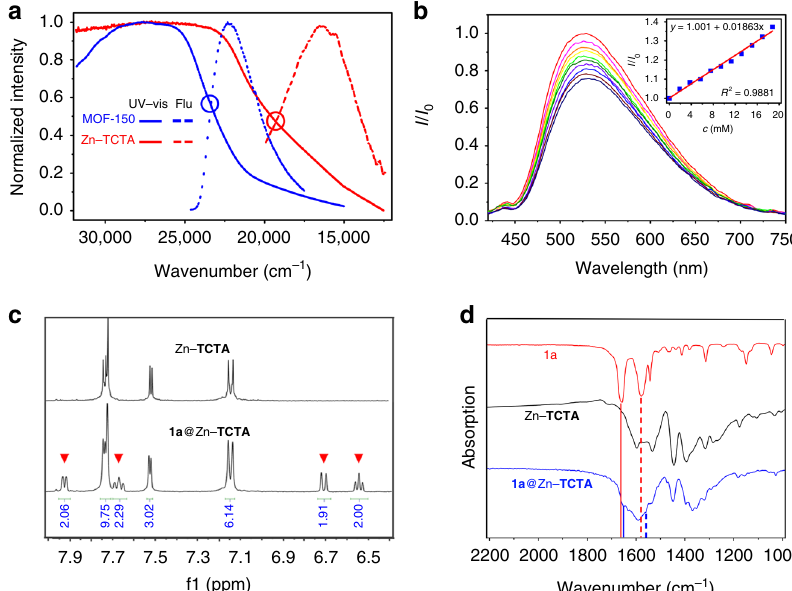
Fig. 2 The host – guest interactions between Zn – TCTA and substrate/reagent. a Normalized absorption and emission spectra of Zn – TCTA ( ν 0 – 0 = 19,274 cm − 1 , E 0 – 0 = 2.39 eV) and MOF − 150 ( ν 0 – 0 = 23,468 cm − 1 , E 0 – 0 = 2.91 eV) excited at 390 and 350 nm, respectively. b Fluorescence spectrum of Zn – TCTA upon the addition of tri fl uoromethanesulfonyl chloride (TfCl) and the corresponding simulated Stern – Volmer curve (inset of b ) excited at 390 nm; the intensity was recorded at 546nm. c 1 H NMR spectrum of the crystals of Zn − TCTA and 1a @Zn − TCTA (digested in DMSO- d 6 /DCl). Peaks marked with inverted red triangles represent the aromatic signals of the encapsulated substrate 1a . d Comparison of the infrared (IR) spectrum of 1a (red line), Zn − TCTA (black line), and 1a @Zn − TCTA (blue